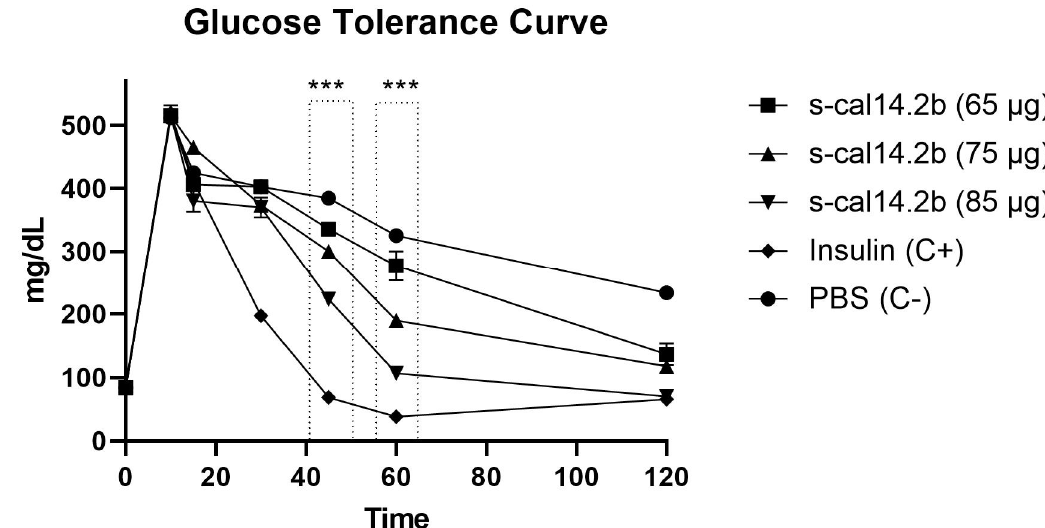
Figure 5. Glucose tolerance in mice following administration of s-cal14.2b. Three different treatments of s-cal14.2b (65, 75, and 85 µ g/20 g body weight) were administered to mice resulting in a concentration-dependent effect of the syn-thetic peptide on glucose levels, when compared to the PBS control group. Modulation of glucose levels by the positive insulin control group (C+) began at 30 min when levels became significantly lower than the negative PBS control group (C − ). By 45 min-post administration, blood glucose levels in the s-cal14.2b groups significantly decreased, compared to the PBS control group. By 120 min, the s-cal14.2b treatment group responded similarly to the positive insulin control group. Results are expressed mean ± SEM assays conducted in triplicate ( n = 3). Statistical significance denoted by *** p < 0.001 between control positive and s-cal14.2b concentrations.